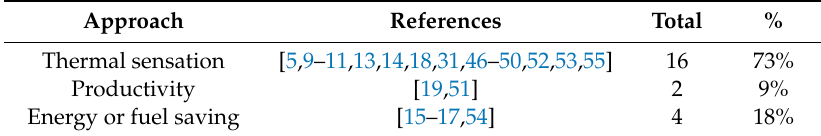
Table 7. Approaches adopted in the objectives of the studies included by this